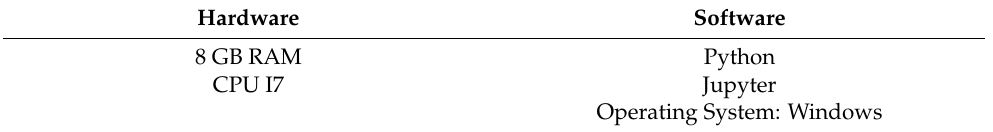
Table 6. Hardware and software requirements for the design of the system. Hardware